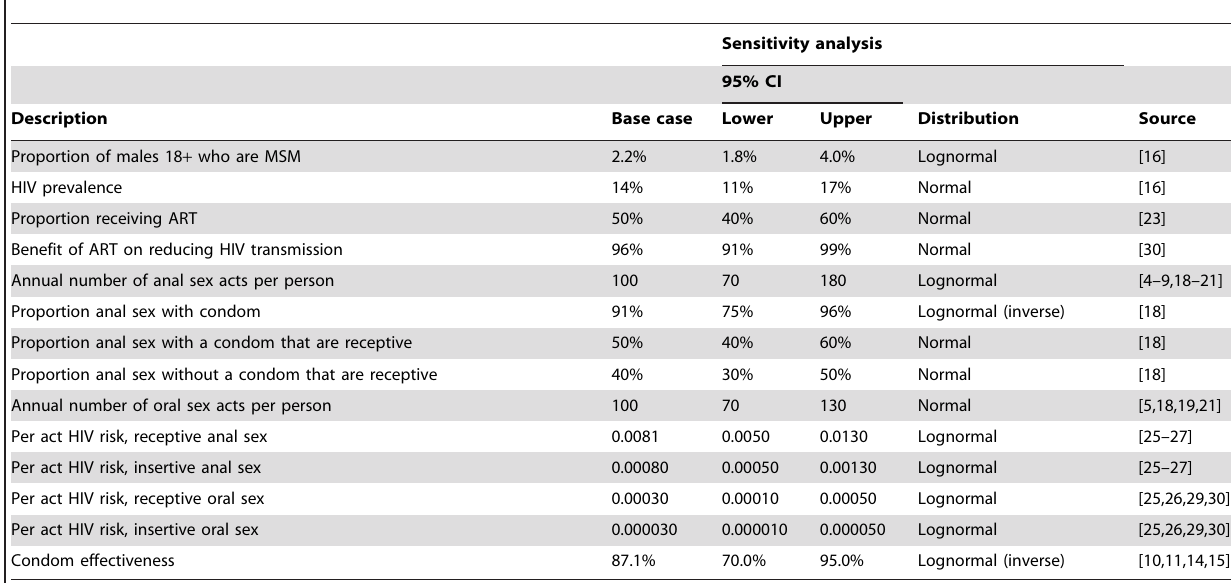
Table 2. Parameter values (base case, lower and upper 95% confidence intervals [CI]) for sensitivity